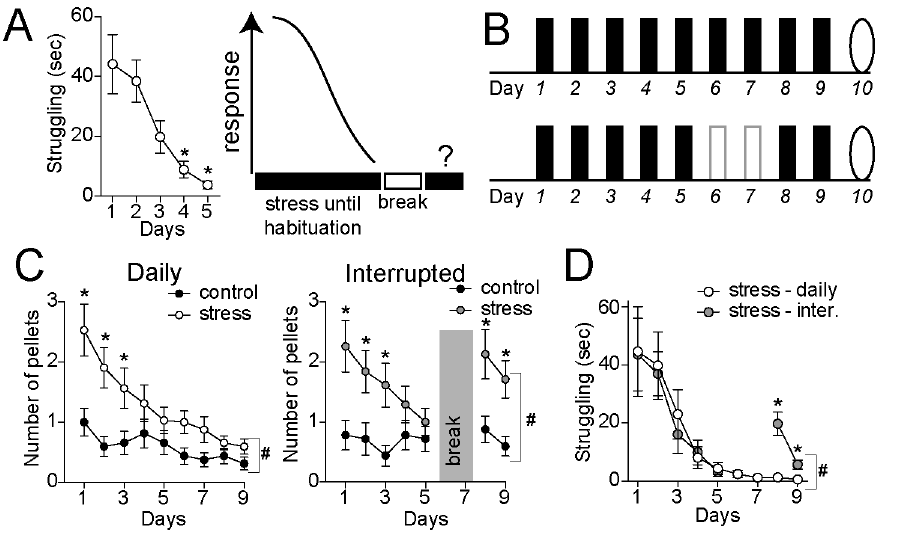
Figure 1. Reduced habituation of fecal pellet production during the interrupted restraint. A) The interrupted restraint protocol was designed to test the effects of an interruption placed shortly after the emergence of habituation to a repeated stressor. Emergence of habituation was initially measured as a significant reduction in struggling behavior during restraint over the course of 5 days. B) In these studies, daily stress was compared to an interrupted stress pattern where a two day interruption was placed after 5 days of daily stress. The solid black bars indicate a stress day, the open bars indicate an interruption day, while the oval indicates the test day. C) Fecal pellet production was counted at the end of each daily stress or control session. Significant habituation of pellet production to control levels was observed by the 5 th day of daily restraint stress. This habituation persisted through the remaining stress sessions in the daily restraint group. Significant habituation of pellet production was also observed in the interrupted restraint group by the 5 th day, prior to the interruption. After the interruption, pellet production increased, and was significantly different than controls. D) The interrupted stress group displayed significantly greater pellet production after the interruption compared to the daily stress group. * indicates p , 0.05 in post hoc tests comparing to the first day of restraint in a one-way ANOVA (A), or comparing control and stress (C) or daily and interrupted stress (D) after significance in a two-way repeated measures ANOVA. Here and in all subsequent figures, inter=interrupted pattern, and daily=daily pattern. # indicates significant Pattern x Day interaction in a two-way